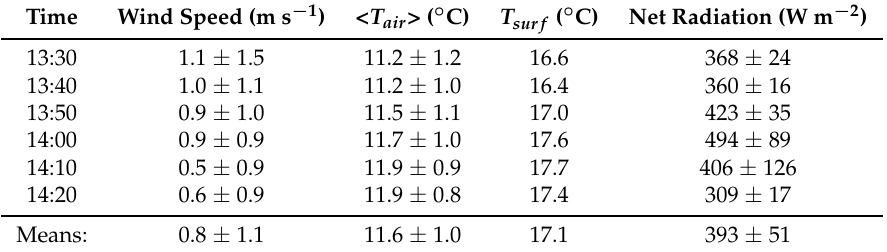
Table 2. Meteorological data (as means) during the flight on 11 April 2018, 13:30–14:20 CET (at 2m above the ground): wind speed, air temperature, surface temperature ( T surf ) at 0.05m and net radiation. Taking into account small spatial temperature variations, T air of both stations (area of flown routes) was averaged (< T air >).